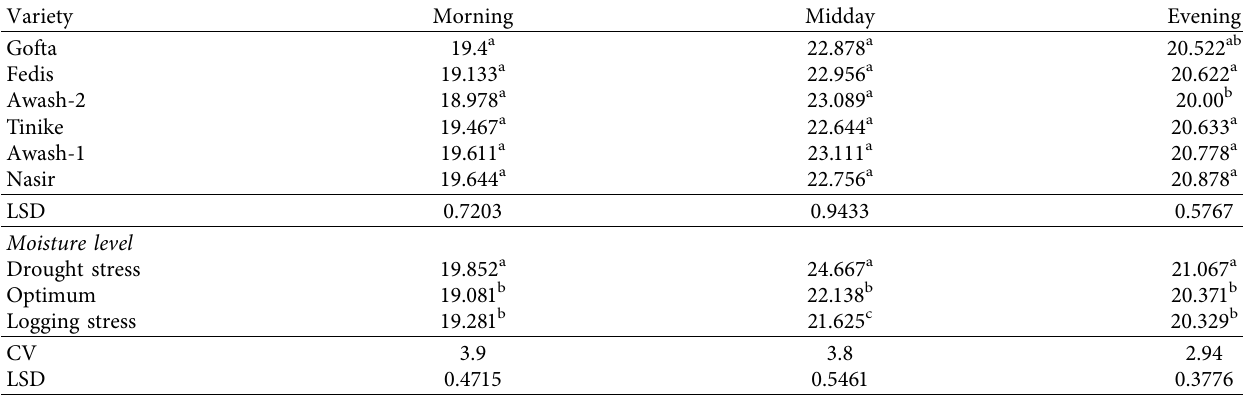
Within the column means with the same letter are not statistically Table 5: Interaction efects of varieties and soil irrigation interval on stomata aperture of common beans under Lath House during June to September, 2020. Irrigation interval